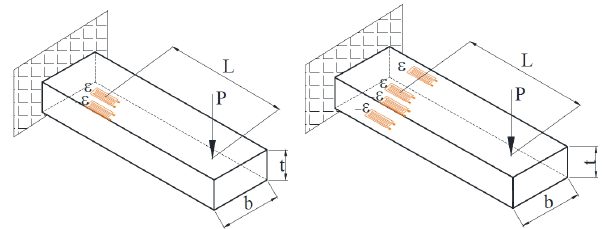
Figure 6. Beam subjected to bending and strain gauge connections in half and complete Wheatstone bridges.